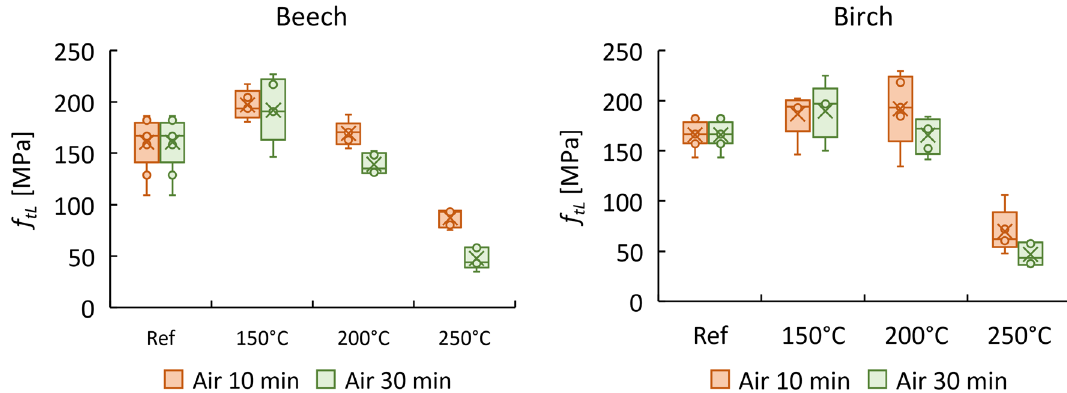
Figure 5. Longitudinal tensile strength ( f tL ) of beech and